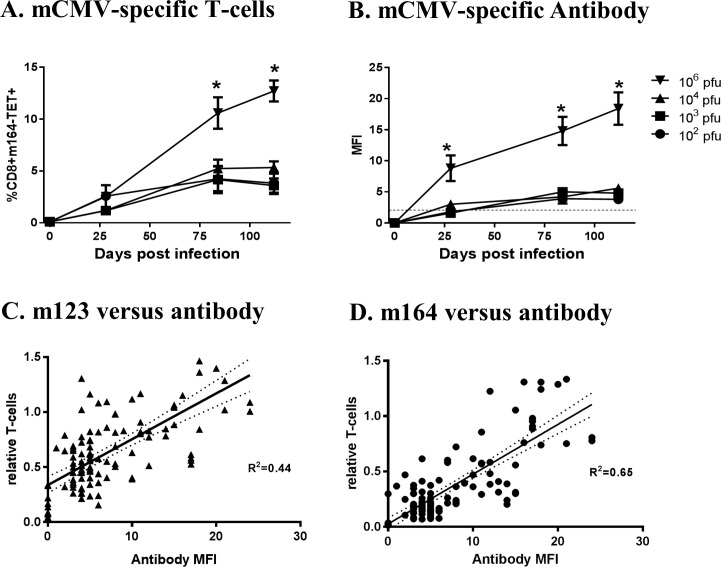
Inflation of murine cytomegalovirus (mCMV) specific T-cells and antibody over time.Mice 8–10 weeks old infected intraperitoneally with 102, 103, 104, or 106 plaque forming units Smith mCMV had peripheral blood obtained longitudinally 4, 12 and 16 weeks after infection evaluated for mCMV-specific T-cells and antibody. A. m164-specific CD8+ T-cells were enumerated by flow cytometry using tetramers. B. Sera were evaluated for mCMV specific IgG by ELISA with results reported in mean fluorescent intensities;—indicates the limit of sensitivity of the assay. For A&B, * indicates significantly higher than all lower titer cohorts (P<0.05). Results represent a single longitudinal experiment with each point/bar representing the mean and standard error for n = 5 mice.